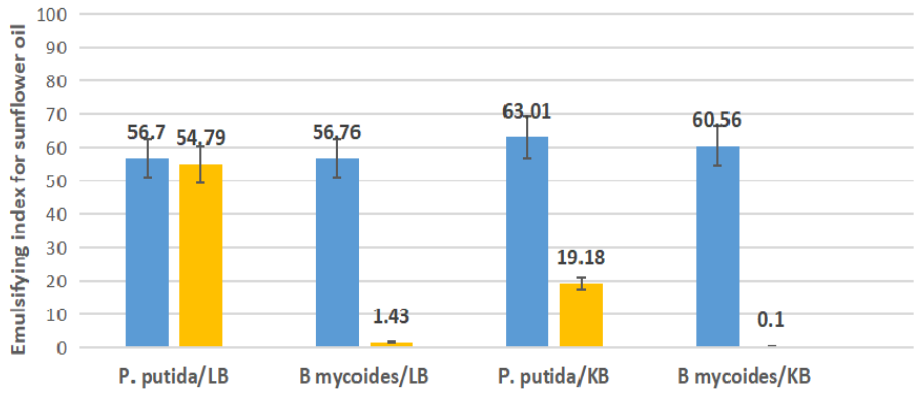
Figure 10. Emulsifying index for sunflower oil (LB and KB).